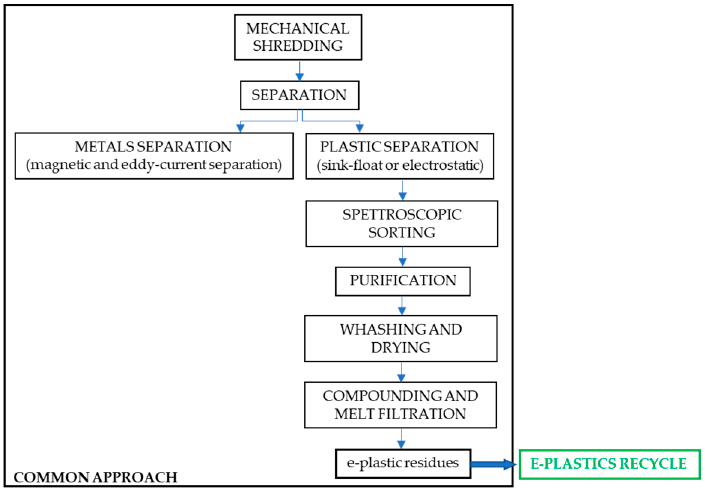
Figure 1. Mechanical recycling (common approach).